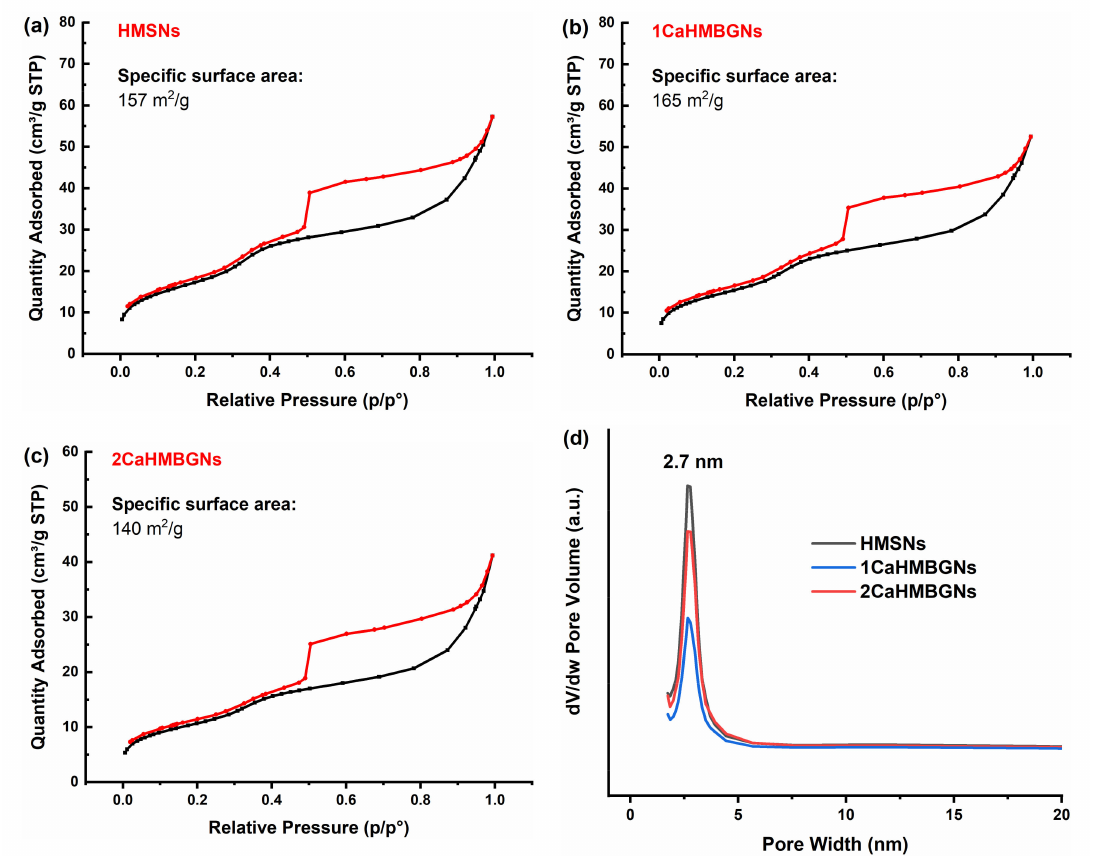
Figure 6. Nitrogen sorption isotherms of ( a ) HMSNs, ( b ) 1CaHMBGNs, and ( c ) 2CaHMBGNs, and their ( d ) pore size